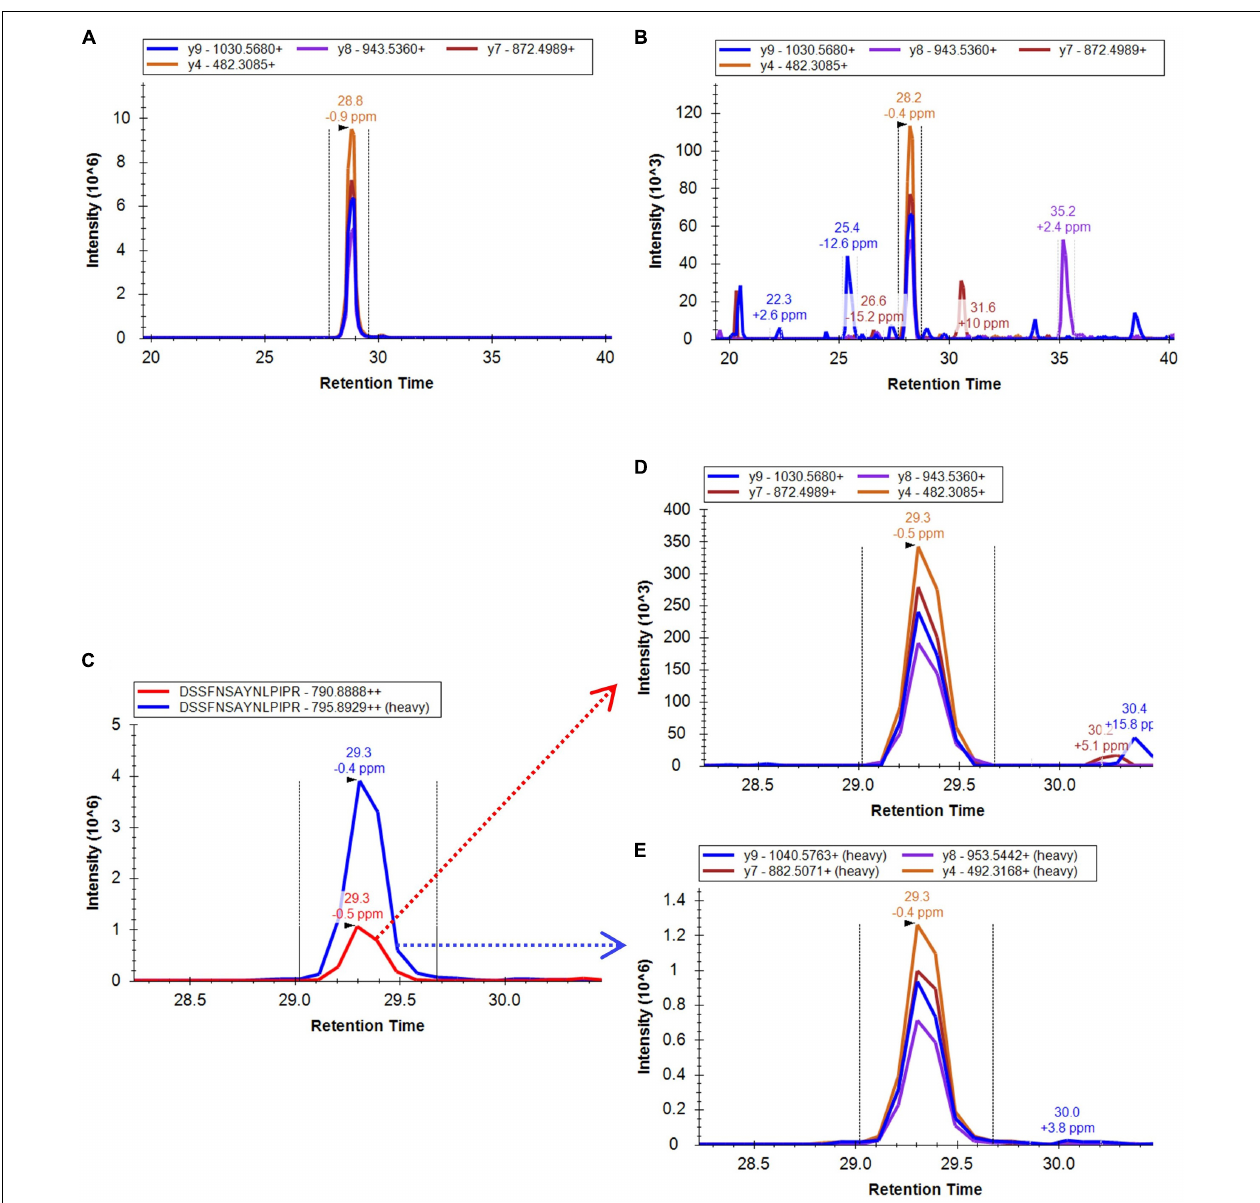
FIGURE 2 | Extracted ion chromatogram of the PRM four most intense fragment ions identified from (A) the synthetic non-labeled peptide DSSFNSAYNLPIPR, (B) an endogenous peptide sample derived from a mature green tomato. (C) XIC of the combined fragment ions of the endogenous peptide (red peak) DSSFNSAYNLPIPR of the protein SlETR4 in a mature green tomato peptide sample and the combined fragment ions of its heavy labeled peptide (blue peak) spiked in the sample. (D) XIC of the four most intense fragment ions used for quantification of the endogenous peptide and (E) the equivalent fragments for the heavy labeled peptide. All data were analyzed by the Skyline